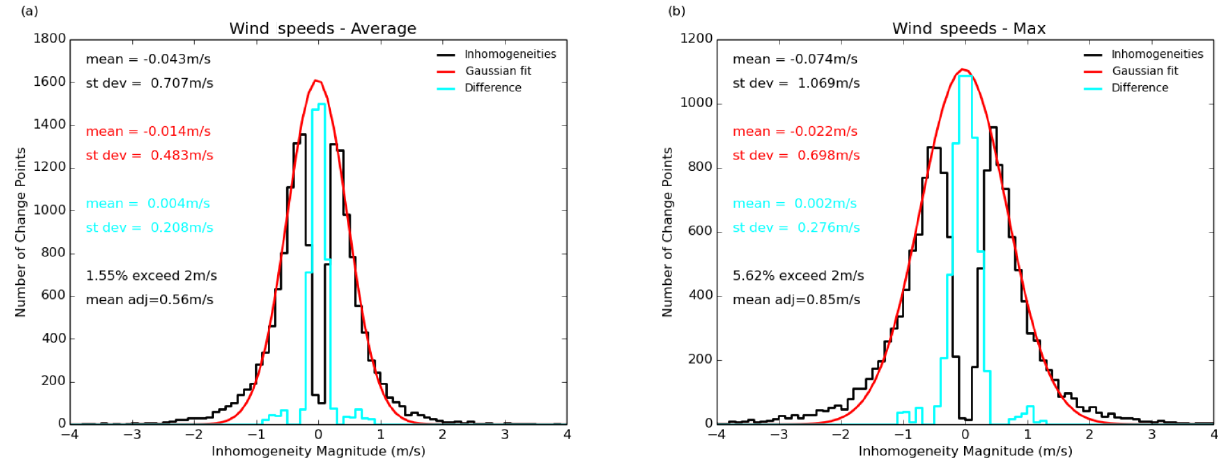
Figure 10. The distribution of the inhomogeneity magnitudes for (a) monthly-mean wind speeds and (b) monthly-mean daily-maximum wind speed. The distributions have been fitted with a Gaussian (red), and the difference between the data and the Gaussian is shown in blue.